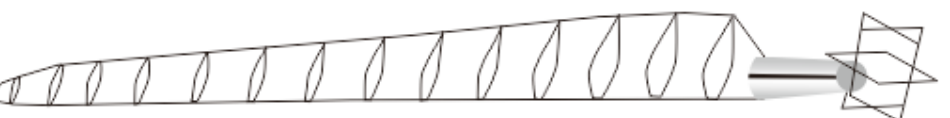
represents the twist